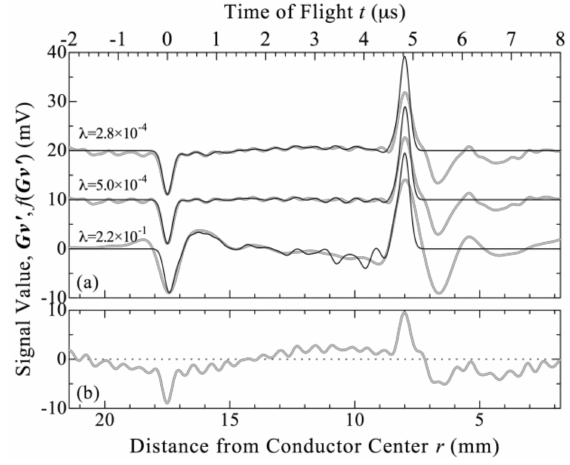
Figure 5. Results of the deconvolution performed on time domain ( a ) and frequency domain ( b ) ob- tained for the subtracted waveform shown in Figure 4, where the tail of the IR is shown by an arrow. The deconvoluted pulse was replaced by the Gaussian shape to be represented as Gv (cid:48) with gray curves. Attenuation correction was superimposed to be represented as f ( Gv (cid:48) ) with black curves. The waveforms in ( a ) were vertically shifted, and the horizontal line was inserted in ( b ) to increase visibility.